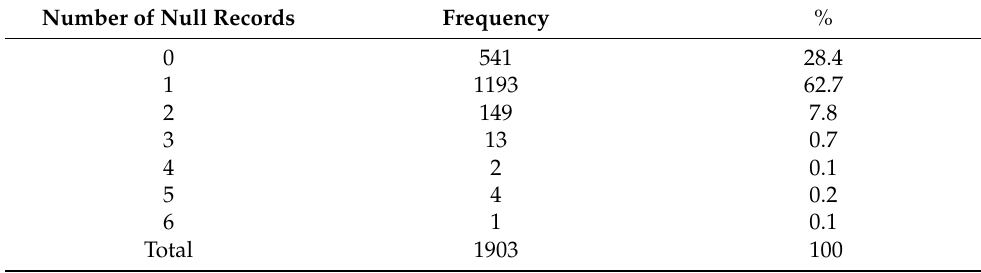
Table 2. Identification of invalid